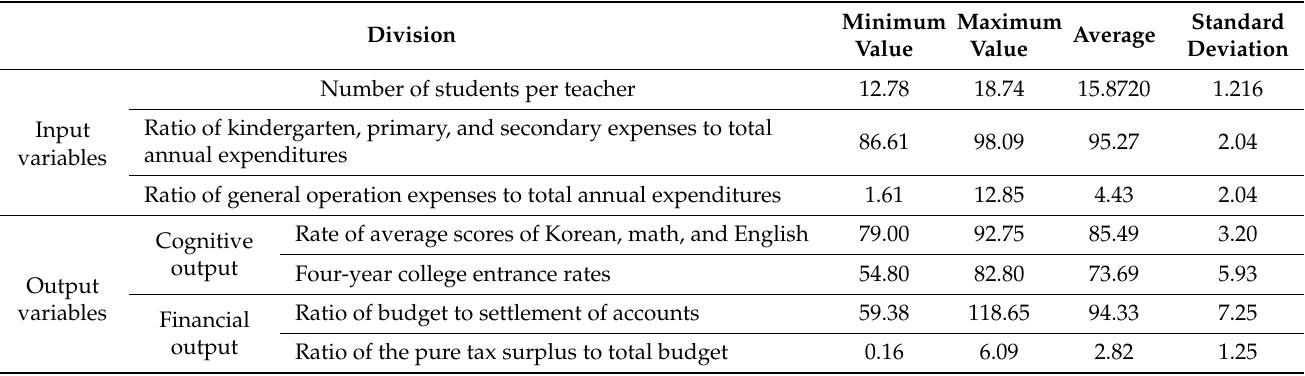
Table 2. The descriptive statistical data for this study.